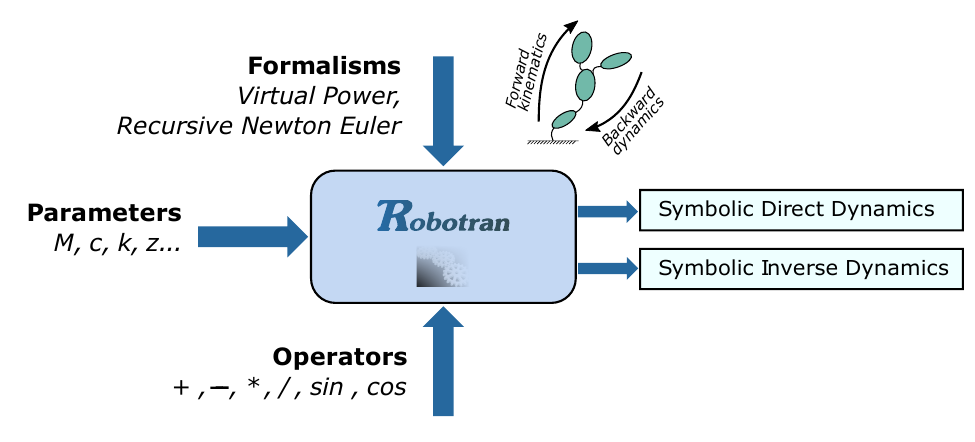
Figure 5. Symbolic Generation